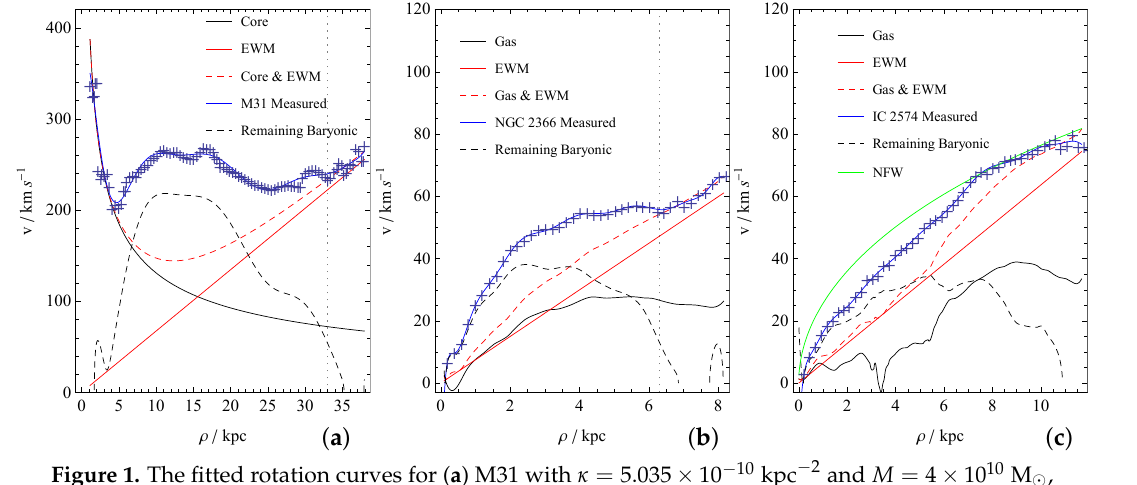
Figure 1. The fitted rotation curves for ( a ) M31 with κ = 5.035 × 10 − 10 kpc − 2 and M = 4 × 10 10 M (cid:12) , ( b ) the dwarf galaxy NGC 2366 with κ = 6.215 × 10 − 10 kpc − 2 , and ( c ) the dwarf galaxy IC 2574 with κ = 4.5 × 10 − 10 kpc − 2 . The blue crosses are the H I -implied rotation speeds taken from Chemin et al. [45] and Oh et al. [48] and the blue curves their polynomial interpolations. The black curves in panels ( b , c ) are the measured gas contributions from Oh et al. [48]. The green curve in panel ( c ) is a CDM profile fit (see Equation (6)) demonstrating that such profiles tend to overshoot the observed rotation curve. Note that the rotation speeds add in quadrature, so accelerations add